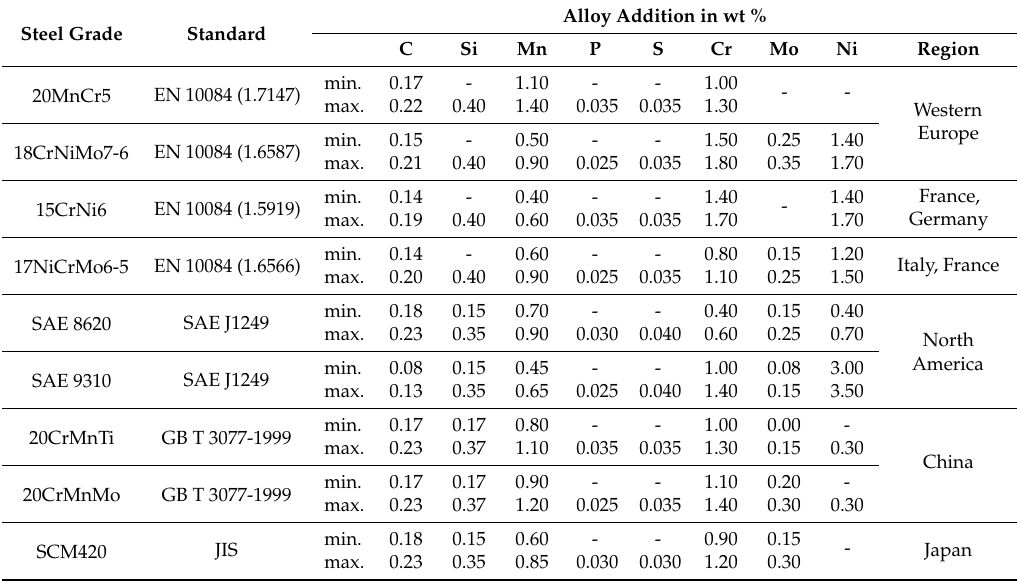
Table 1. Major carburizing steel grades for medium- and large-sized gears in various geographical